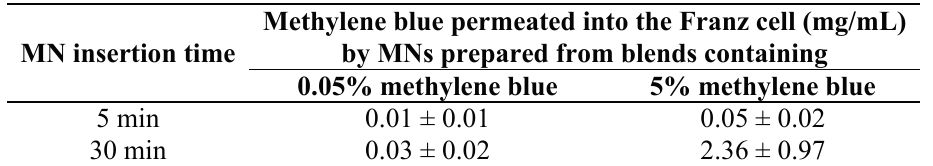
Table 1. Methylene blue released by MN after 5 and 30 min of insertion across aluminum foil paper on a Franz cell setup (Means ± S.D., n =